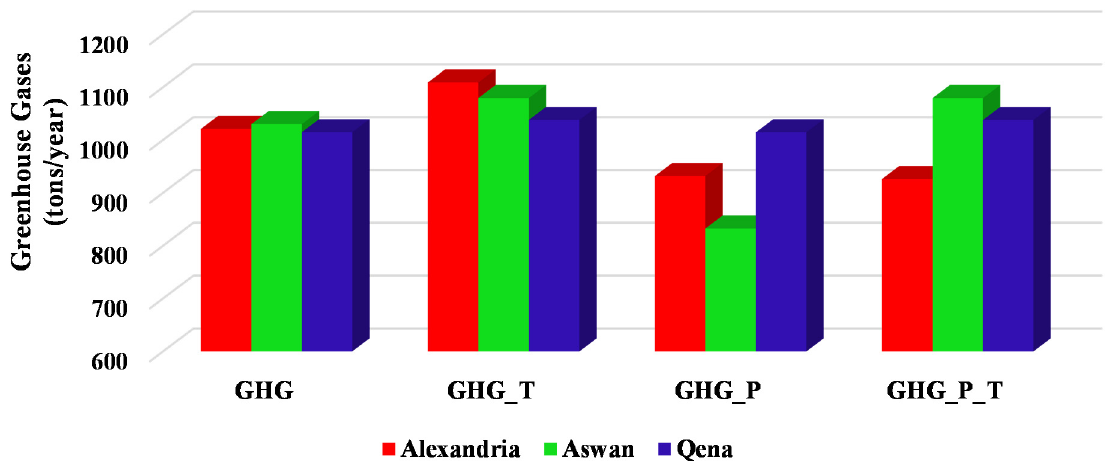
Figure 12. The different amounts of GHG emitted from a PV/wind/diesel/battery system in Alexandria, Aswan and Qena.